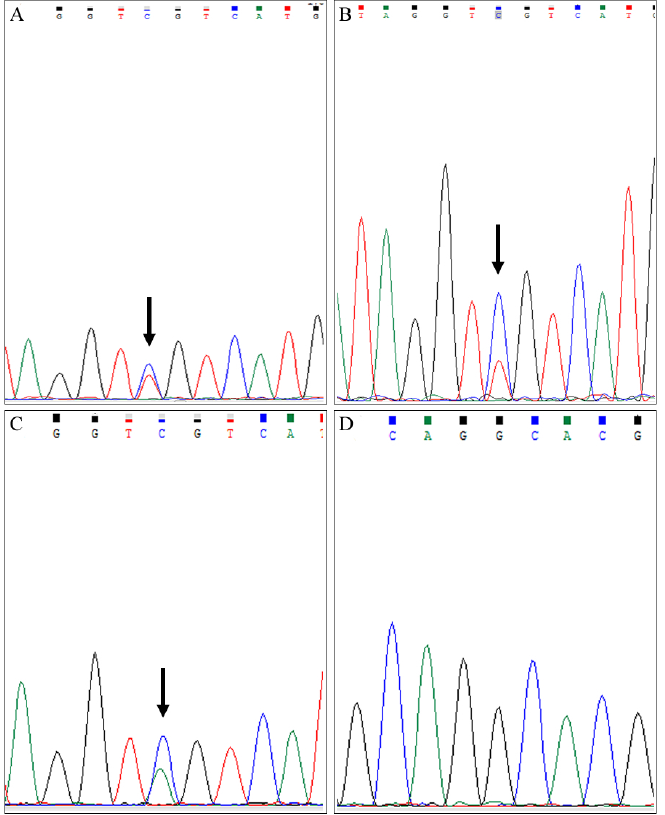
Figure 2. ( A ) IDH1 mutation in ovarian tumour: p.R132C (c.394C > T) (indicated by arrow). ( B , C ) IDH1 mutations in cartilage tumours: p.R132C (c.394C > T) (indicated by arrow) and p.R132H (c.395G > A) (indicated by arrow). ( D ) IDH2 mutation: wild type. Table 2. Detection of IDH1 mutation in 16 tumours.